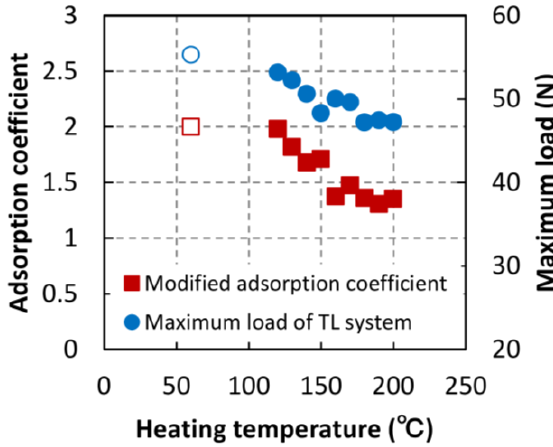
Figure 8. Langmuir’s modified adsorption coefficients for heated specimens.